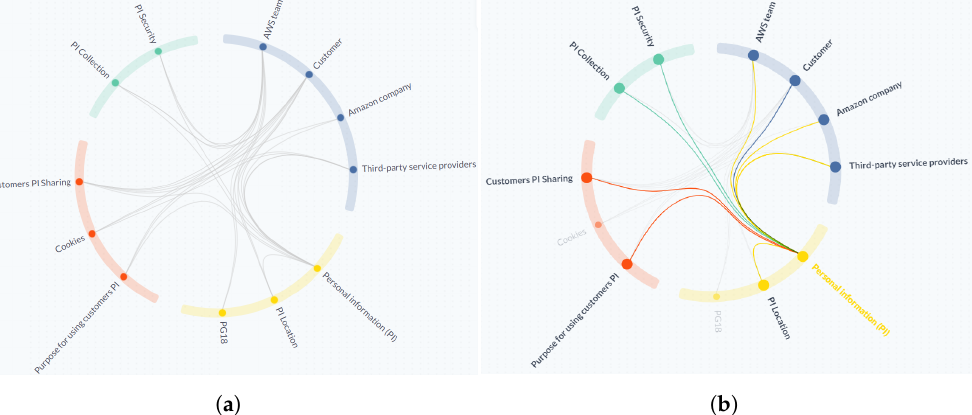
Figure 10. T RANSP V IS : ( a ) Circle view of AWS keywords and ( b ) mouse-over action of “Personal Information” in AWS